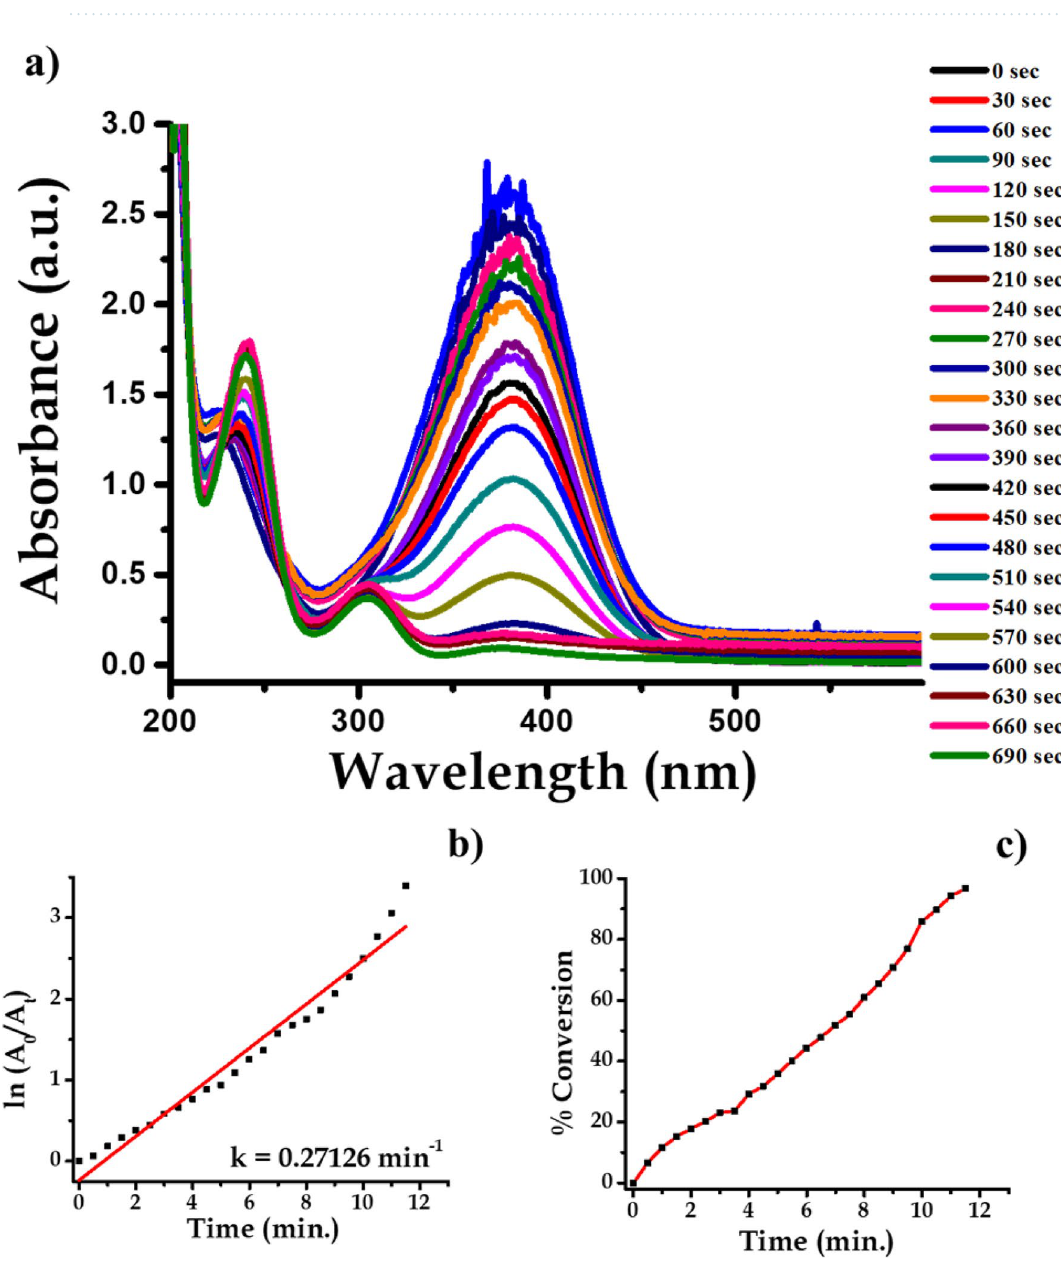
Figure 18. UV–Vis absorption spectra of ( a ) 4-nitroaniline, ( b ) kinetics of catalytic reduction and ( c ) percentage conversion of